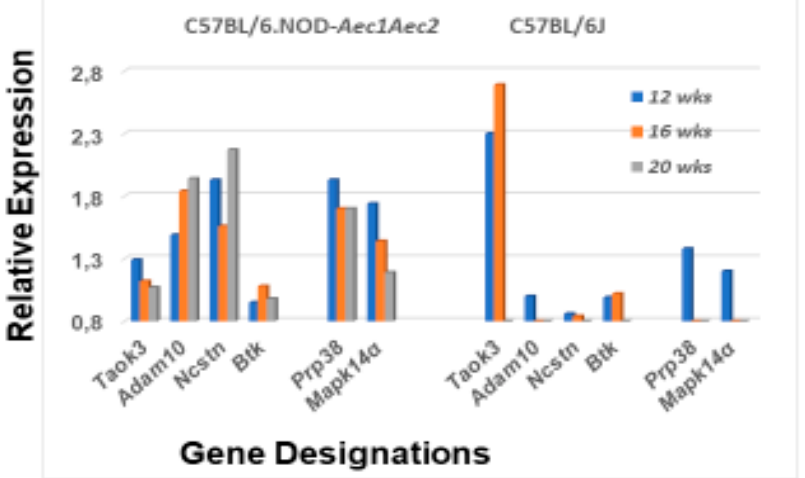
Figure 6. Differential expression profiles for genes encoding various factors involved in the regulation of MZB cell signal transductions. Comparative transcriptome data showing the temporal expression of genes encoding factors critical in controlling the Notch2 signal transduction pathway of MZB cells, i.e., Taok3 ( TAO kinase 3) , Adam10, Ncstn (nicastrin) , Btk (Bruton’s tyrosine kinase) , Prp38 (proline rich protein 38) and Mapk14a (mitogen-activated protein kinase 14a) in salivary glands of SS S C57BL/6.NOD- Aec1Aec2 mice ( left ) versus SS NS C57BL/6J mice ( right ).